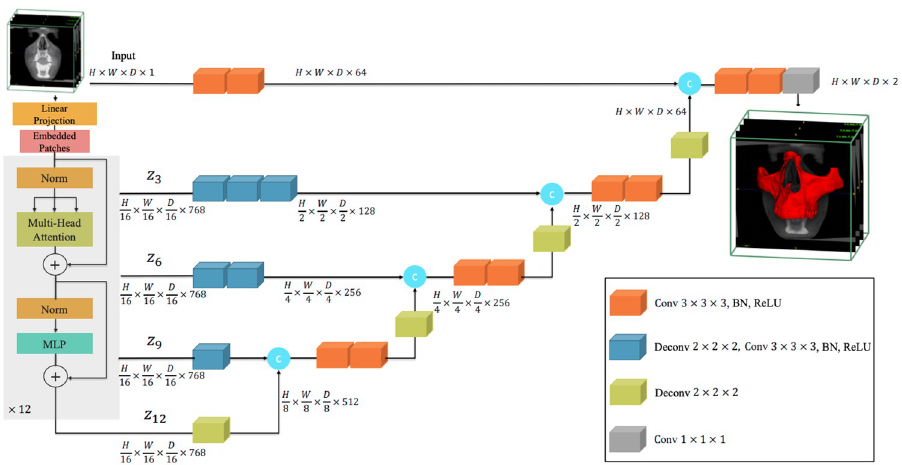
Fig 3. Overview of the UNETR used. A 128x128x128x1 cropped volume of the input CBCT is divided into a sequence of 16 patches and projected into an embedding space using a linear layer. A transformer model is fed with the sequence added with 768 position embedding. Via skip connections, the decoder will extract and merge the final 128x128x128x2 crop segmentation from the encoded representations of different layers in the transformer.